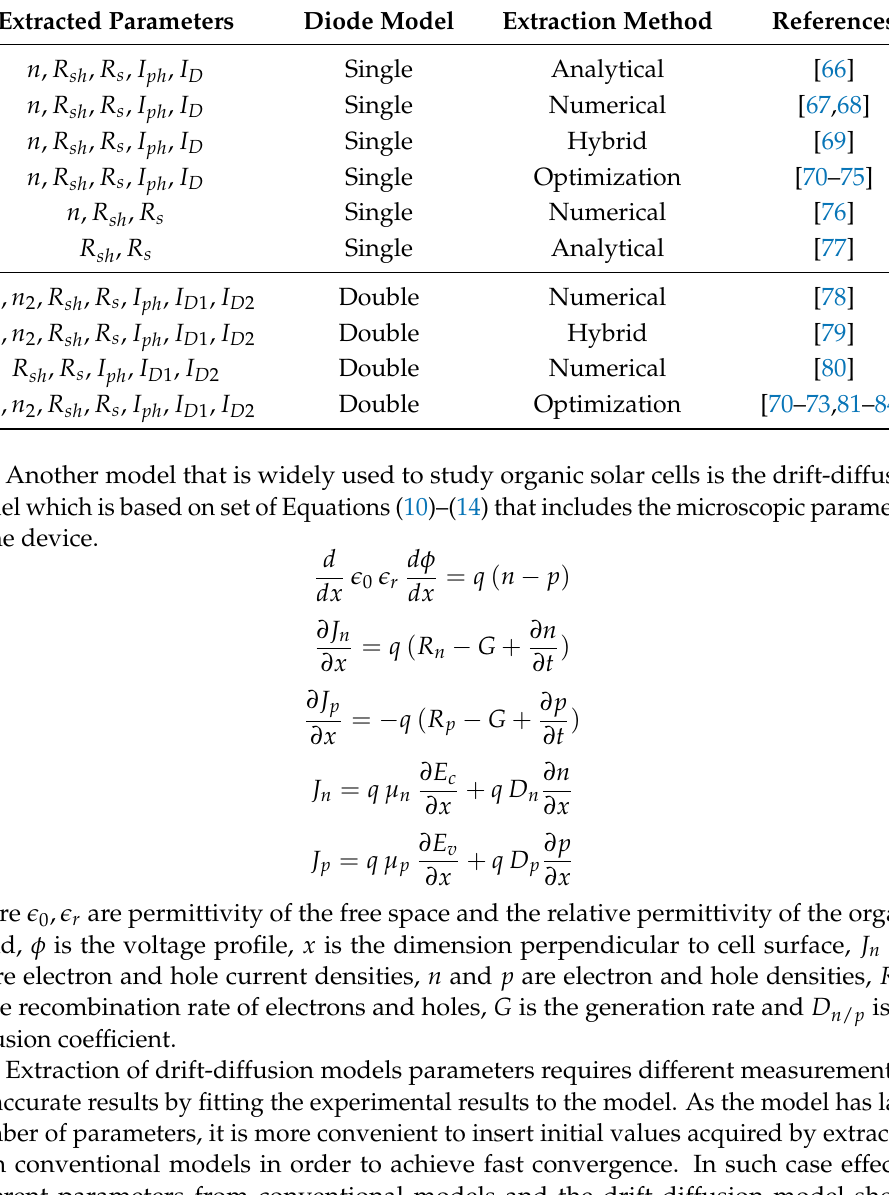
Table 1. List of solar cell models for parameter extraction based on single and double diode models. Extracted